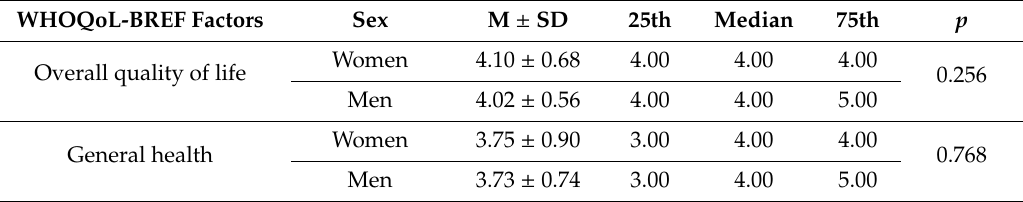
Table 4. Medians, 25th and 75th percentiles, means (M), and standard deviations (SD) for the Quality of Life-brief Questionnaire (WHOQoL-BREF), with a breakdown by sex using the Mann–Whitney U test. WHOQoL-BREF Factors Sex M ± SD 25th Median 75th p Overall quality of